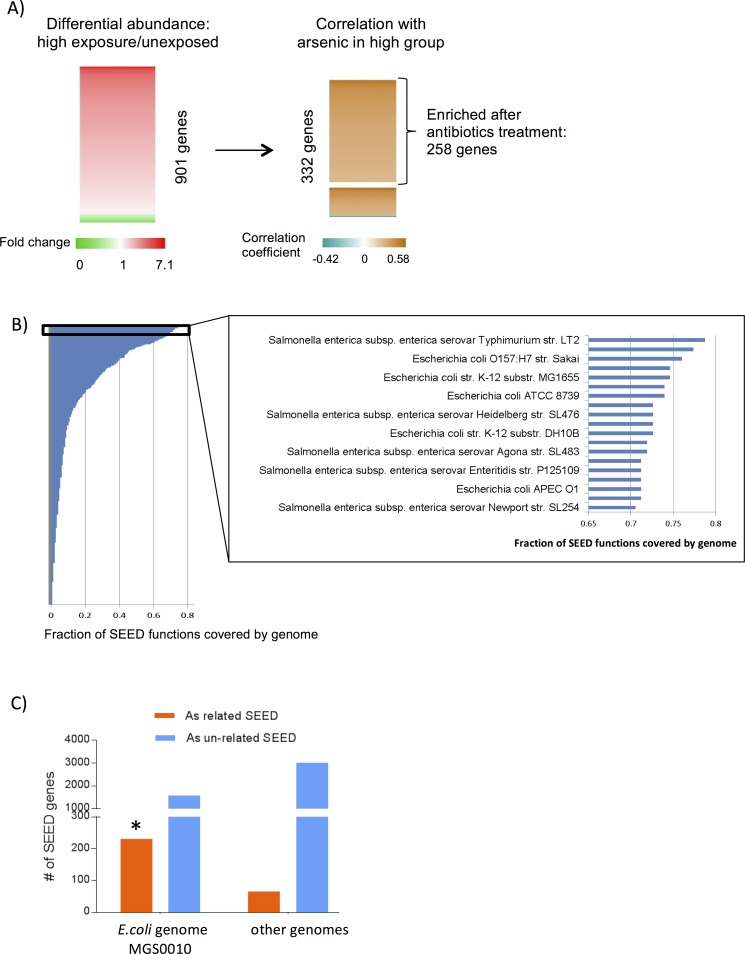
Whole genome shotgun sequencing detected microbial SEED functions associated with arsenic level.(A) Heatmap showing fold change of 901 different abundant SEED functions between high exposure versus low exposure group and correlation coefficients (Spearman) with arsenic levels in high exposure group for 332 SEED functions. The 332 SEED functions either have higher abundance in high exposure group and positively correlated with arsenic level in high exposure group or have lower abundance in high exposure group and negatively correlated with arsenic level in high exposure group (Fisher combined FDR <0.1). Brackets mark 258 SEED functions that also had increased relative abundance in mice after treatment by four antibiotics (ampicillin, neomycin trisulfate, vancomycin, metronidasole) [27]. (B). Fraction of the 332 overlapping SEED functions covered by reference microbial genomes. Those covering more than 70% of 332 gene set are listed. C) Distribution of Arsenic related and non-related SEED genes in assembled genome MGS0010 (E.coli) and other genomes. *Chi-squared test odds ratio 6.69, FDR 1.08e-48.